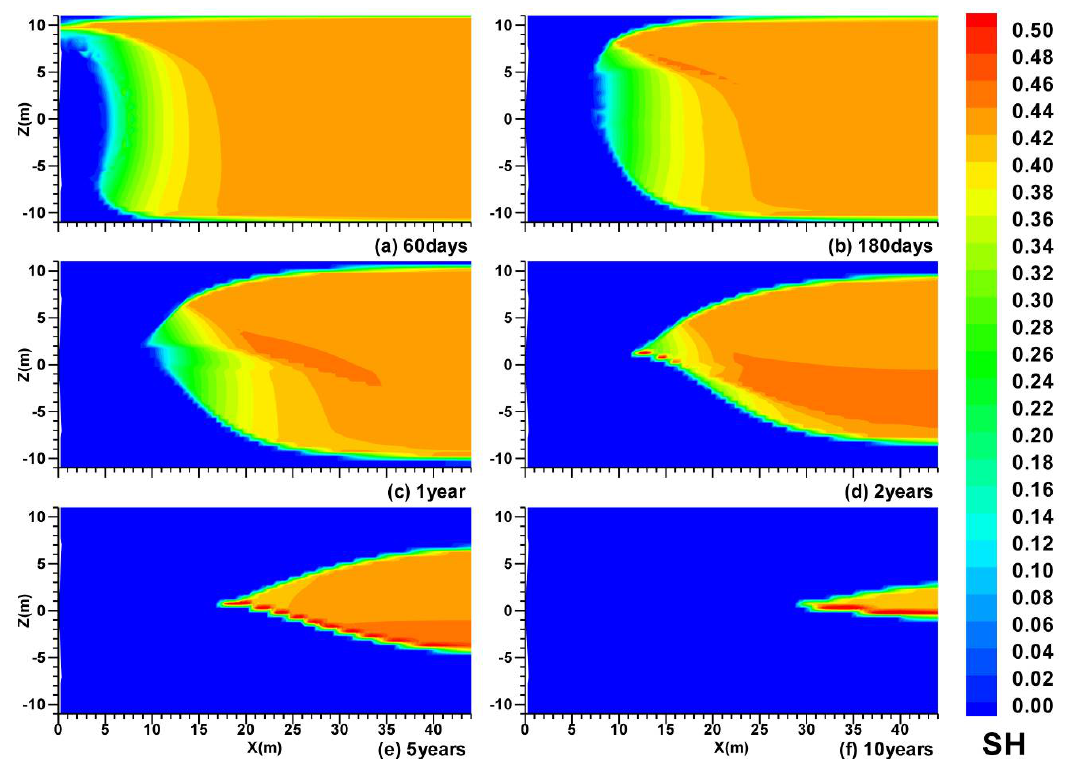
Figure 4. Evolution of spatial distribution of S in Case